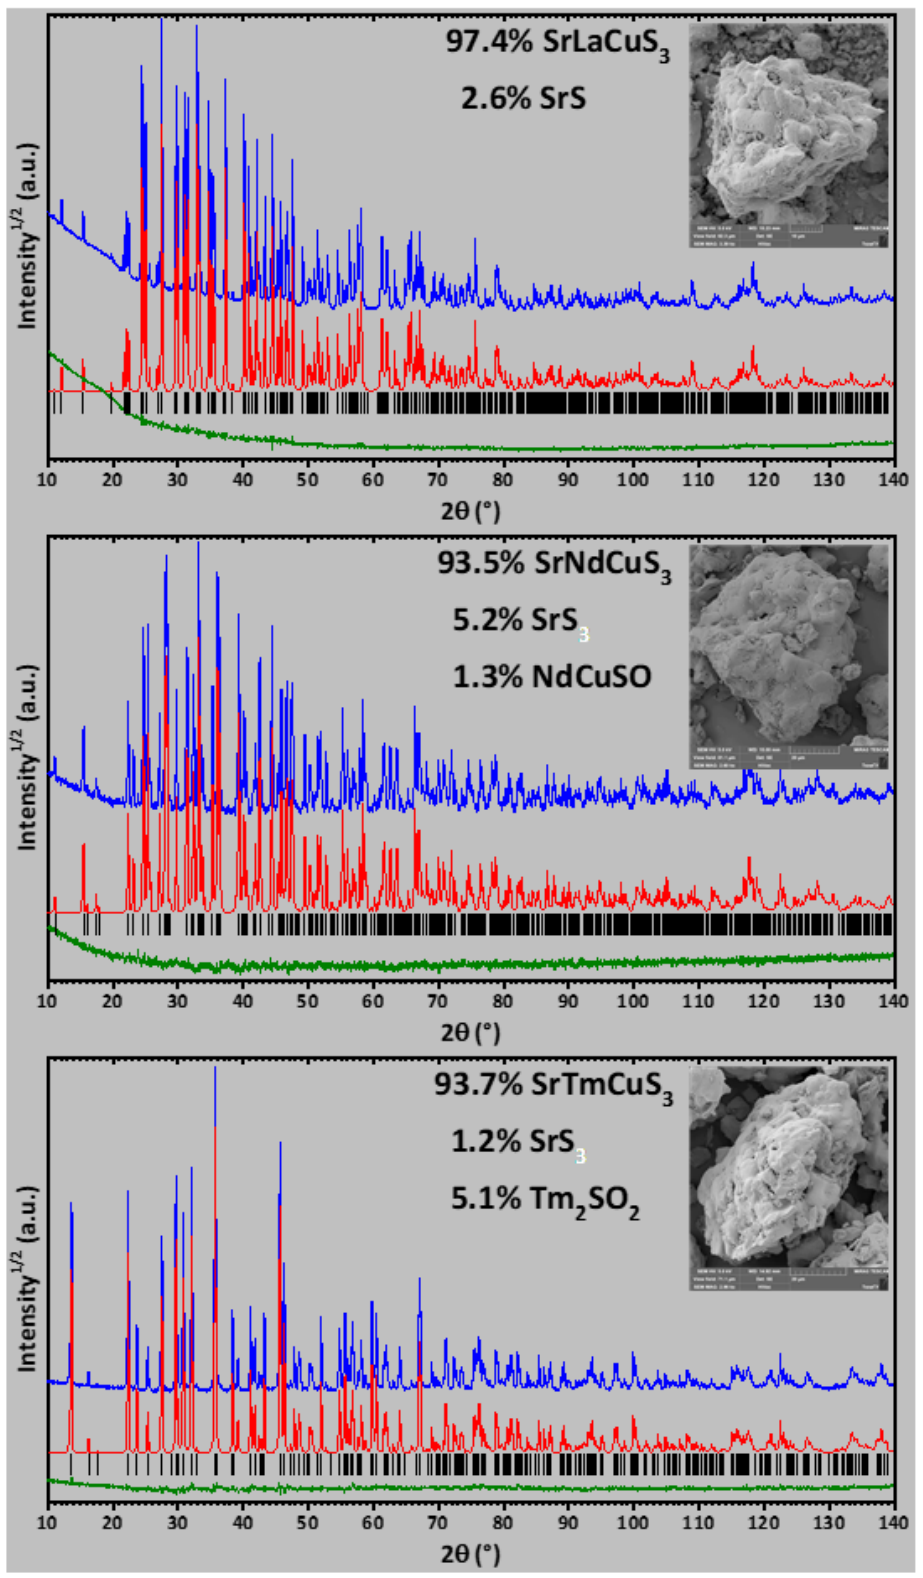
Figure 5. Observed (blue), calculated (red) and difference (green) X-ray powder diffraction patterns for SrLnCuS 3 after crystal structure refinement. Insets show the SEM images of SrLnCuS 3 .